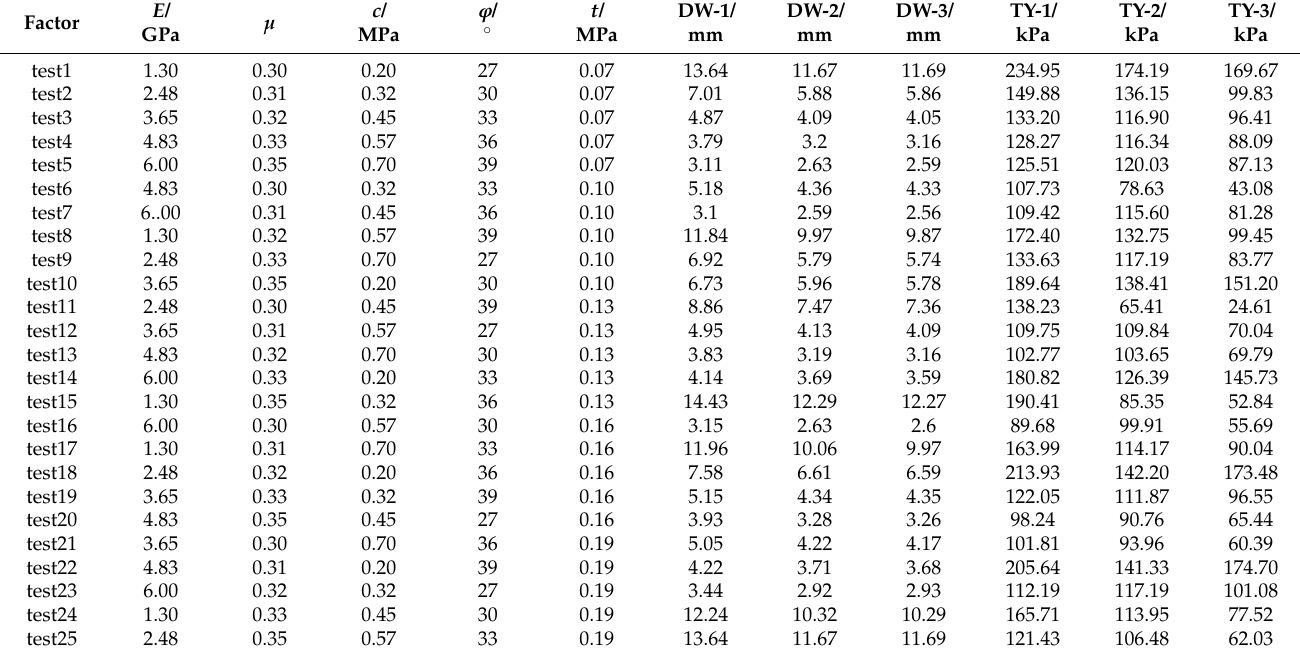
Table 4. Parametric orthogonal experiment scheme.